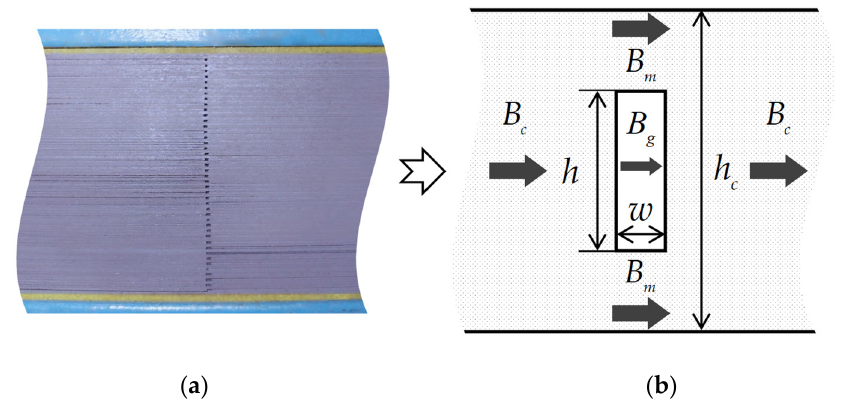
Figure 1. ( a ) Photo of the discontinuous air gap region within a transformer core in our laboratory; ( b ) the simplified air gap setting (top view).